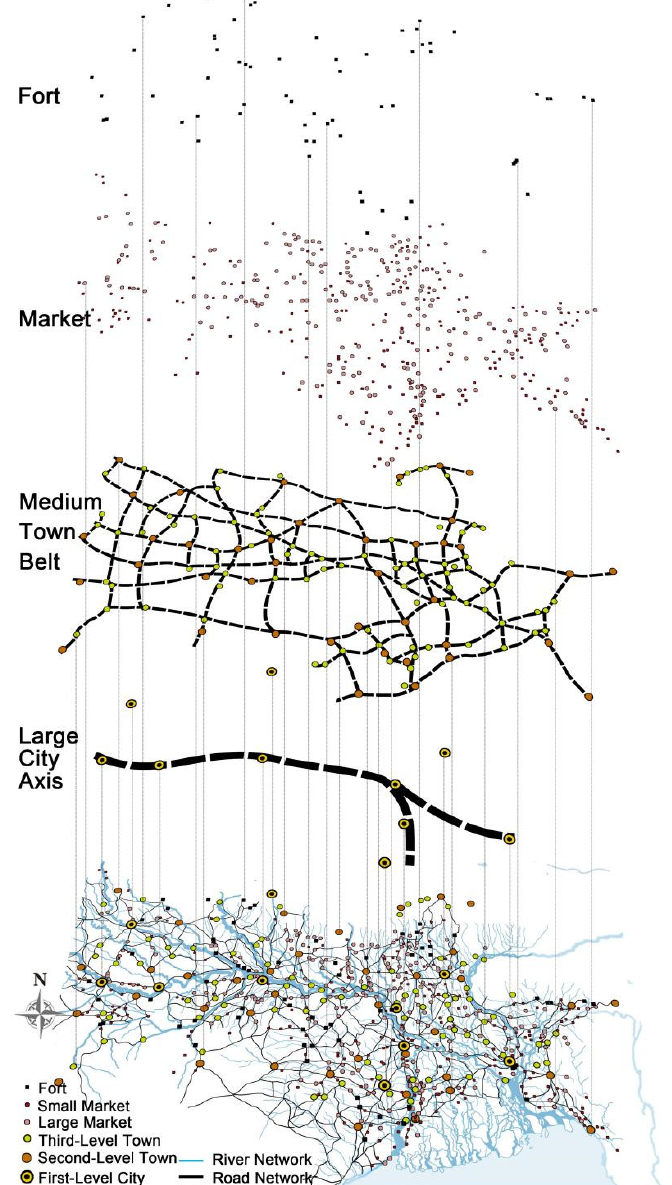
Figure 11. Schematic diagram of the spatial pattern of the city networks in the middle and lower Ganges Valley in the mid-18th Century. Source: the authors; Base Map: Google satellite map; Reference: [65].